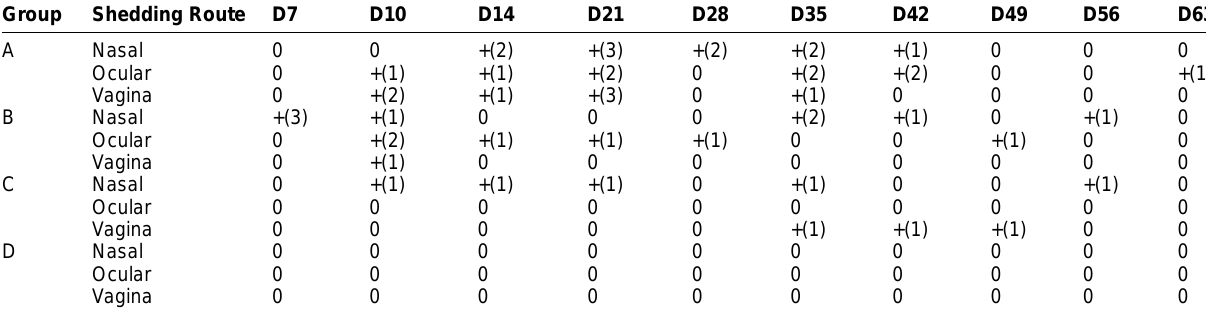
Table-1. PCR result for Nasal, Ocular and Vaginal swabs that were tested for B. melitensis .